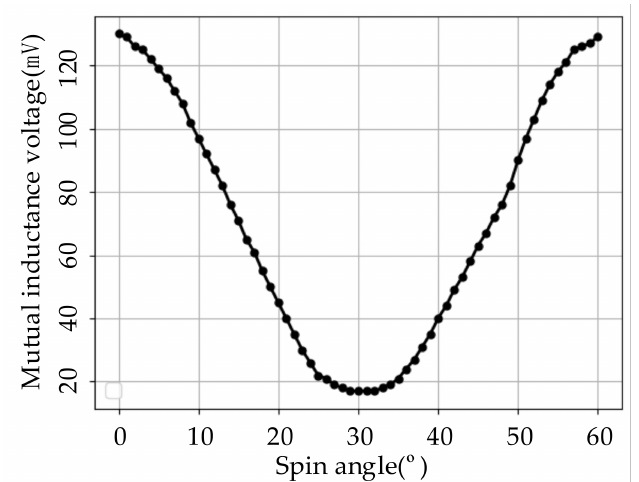
Figure 6. Mutual inductance voltage measurement value of group 5 coil at yaw range of 60 ◦